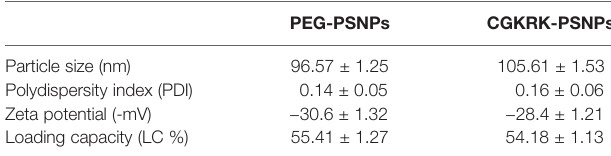
TABLE 1 | Characterizations of various nanoparticles.